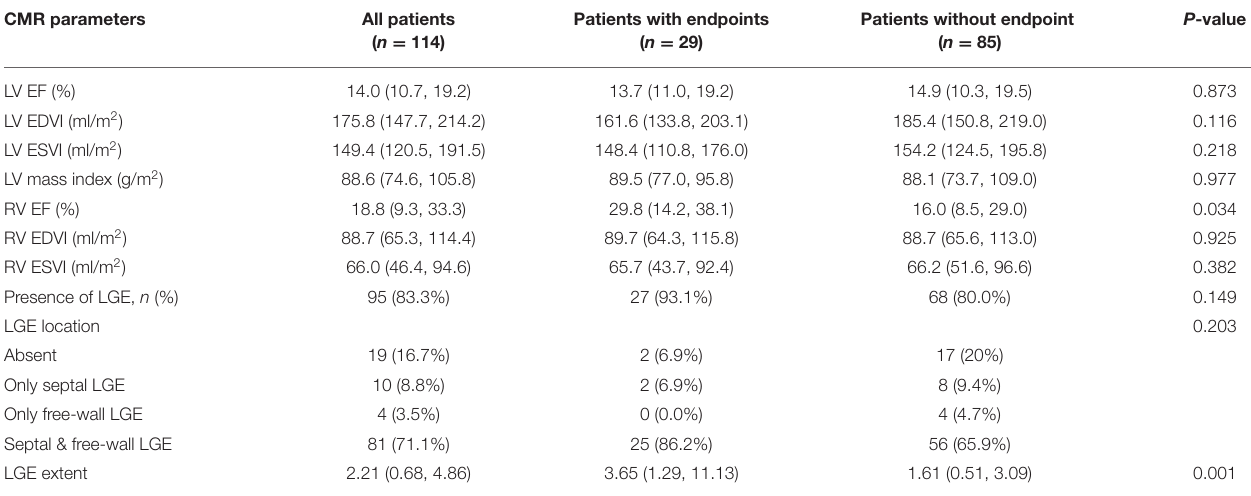
TABLE 2 | Baseline cardiac magnetic resonance (CMR) parameters. CMR parameters